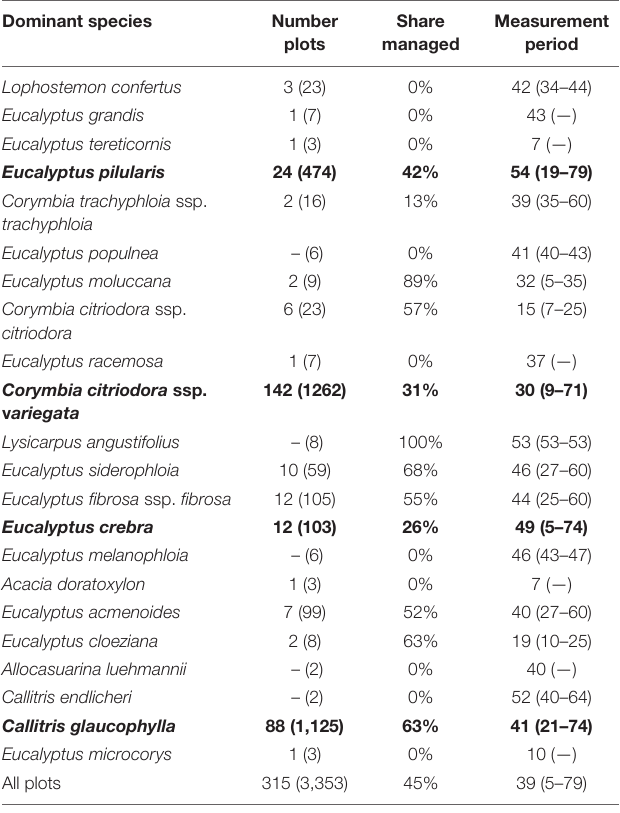
TABLE 1 | Number of observations, the share of managed plots and the time period over which they were measured, grouped by dominant